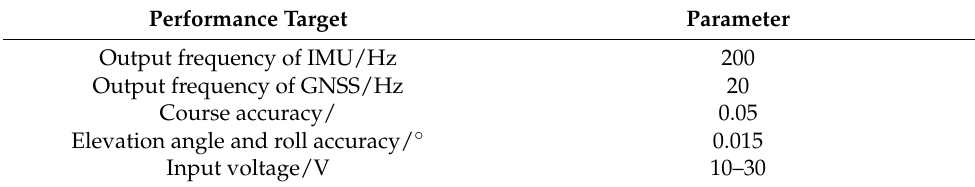
Table 2. Main parameters of integrated navigation